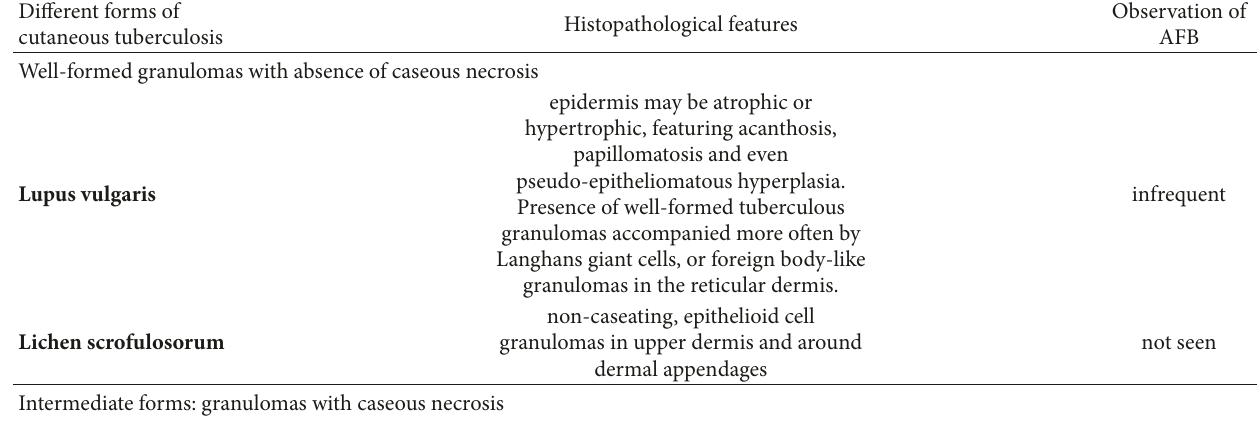
Table 3: Histopathological features of cutaneous